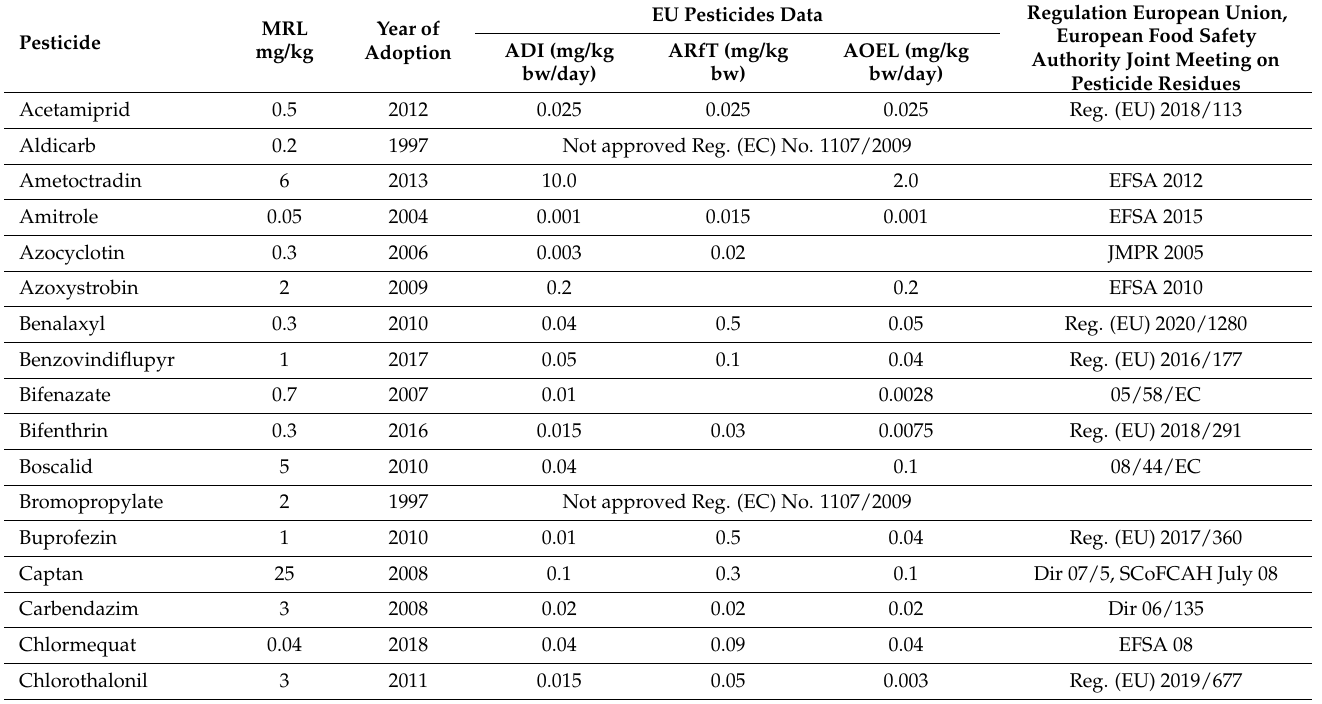
Table 1. Maximum residue limit (MRL) in grapes [table adapted from ref.